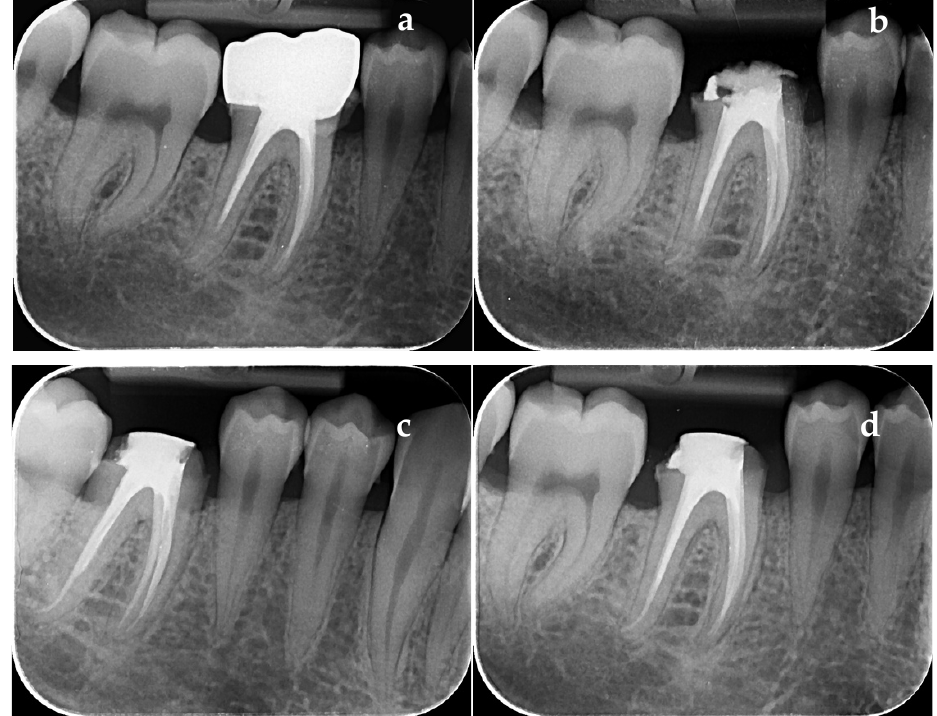
Figure 1. Radiological examination performed preoperatively and postoperatively at intervals of 3 months, 6 months and 12 months, ( a ) initial periapical lesion; ( b ) 3 months after endodontic treatment; ( c ) 6 months after endodontic treatment; ( d ) 12 months after endodontic treatment.